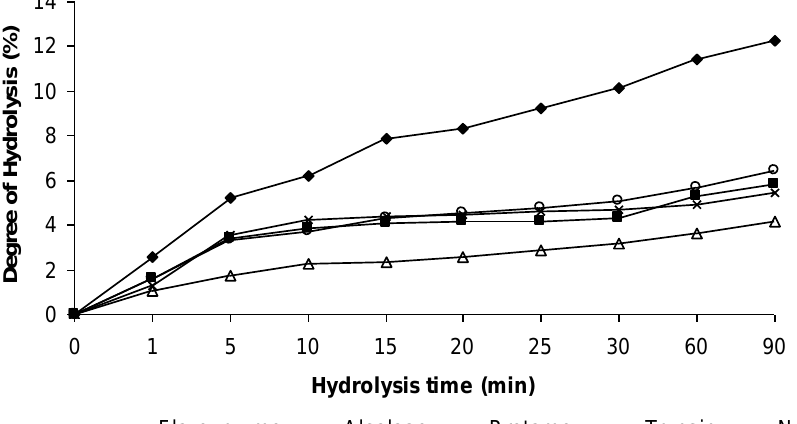
Figure 1. Hydrolysis curves of defatted corn protein with five different protease